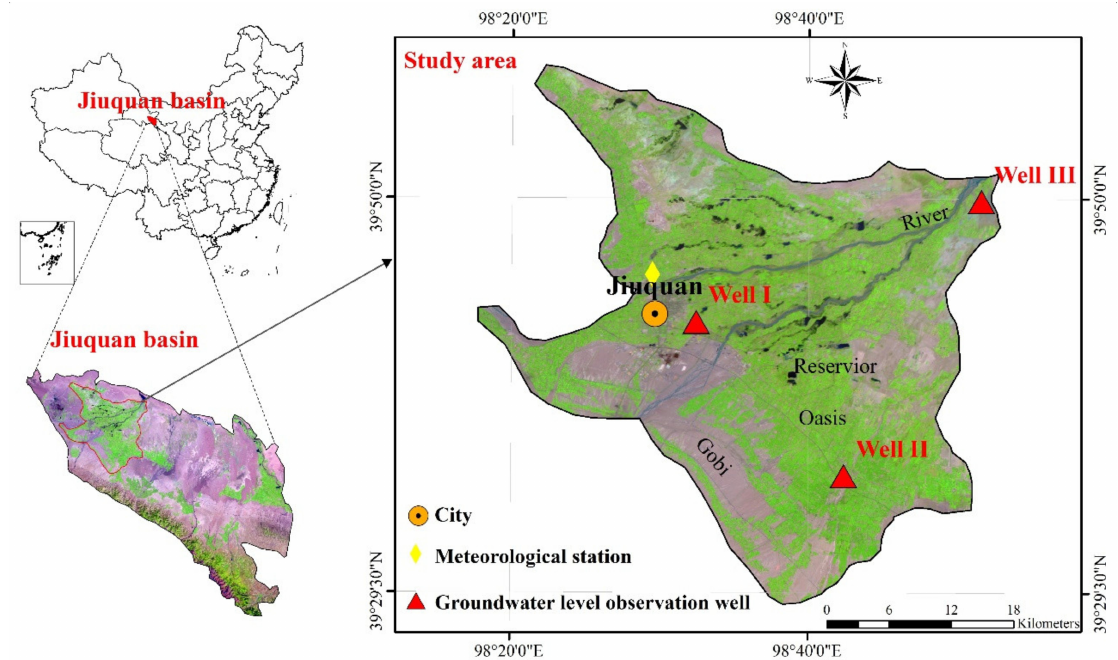
Figure 2. Location of the Jiuquan basin, the study area, the groundwater level observation wells and the meteorological